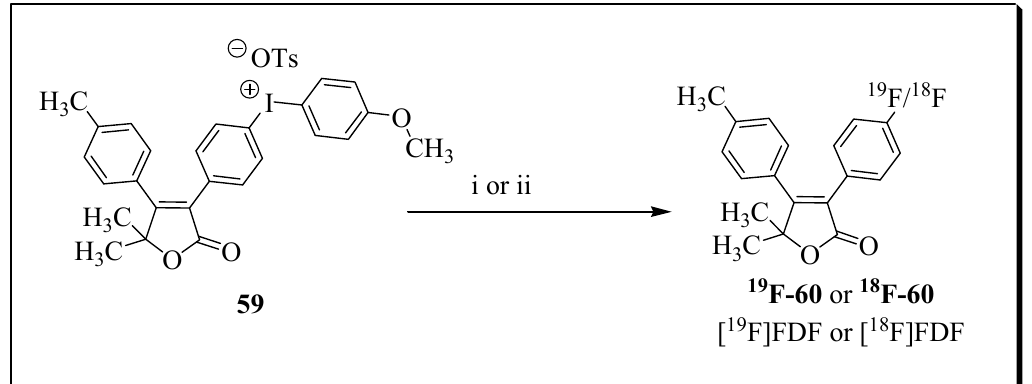
Figure 18. Synthesis of [ 18 F]FDF: (i) [ 19 F]-Bu4NF, m-CPBA, DMSO, 80 °C, 30 min; (ii) Bu 4 NHCO 3 , 18 F- fluoride, m -CPBA, DMSO, 80 °C, 30 min.